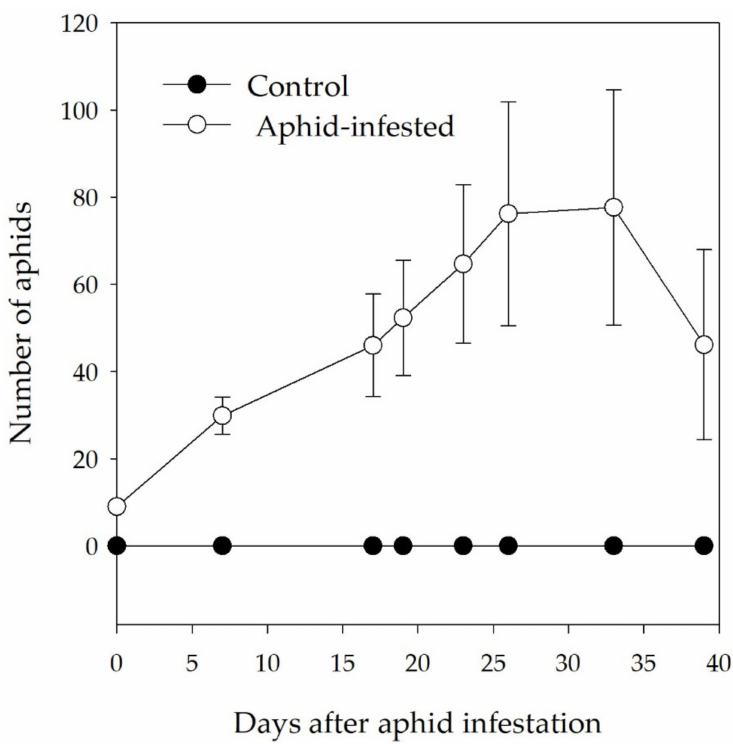
Figure 1. Aphid nymphs and adults (mean ± SE) counted on infested and uninfested branches during 2015 (Experiment